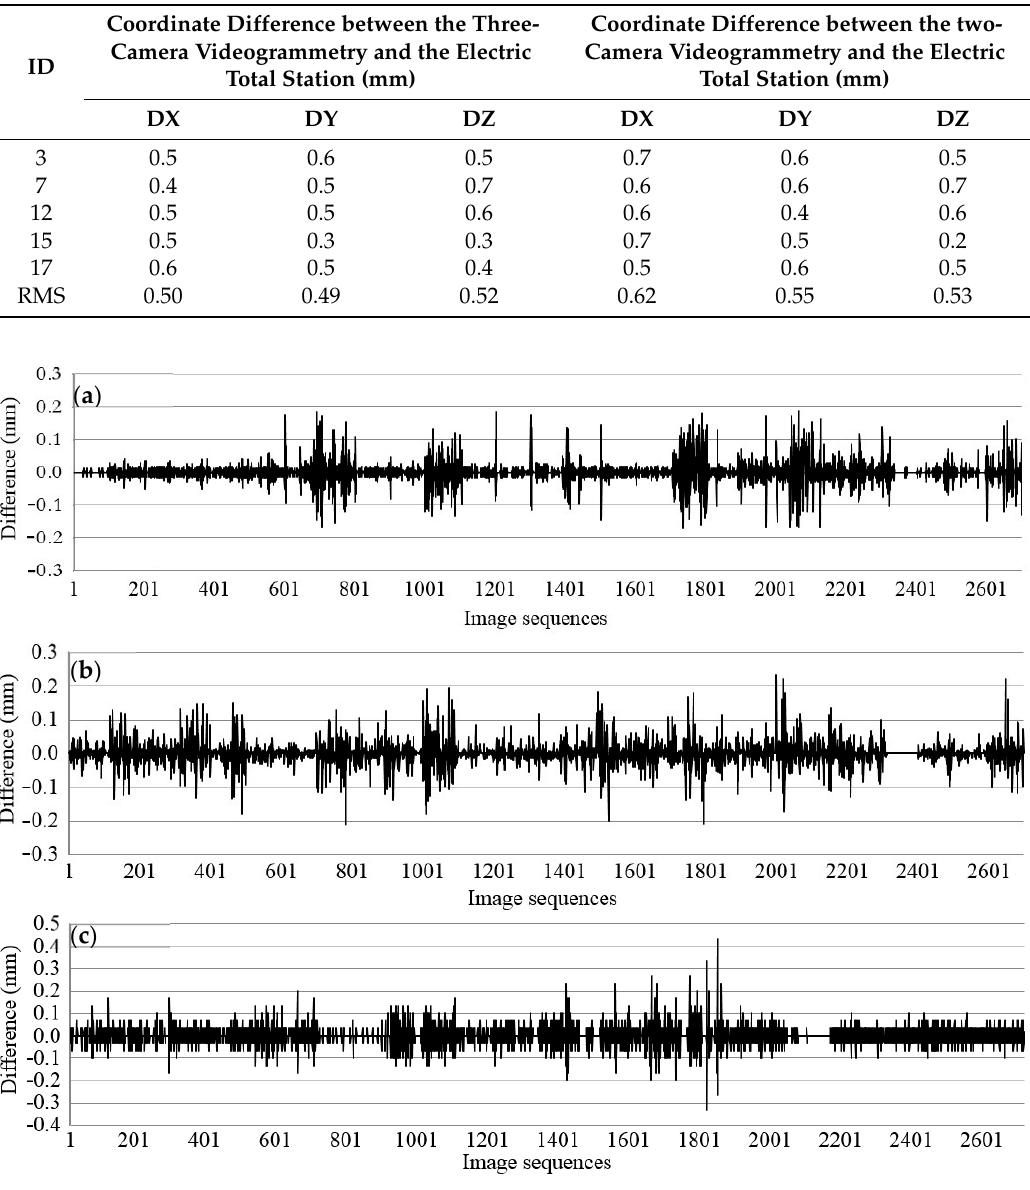
Table 3. Accuracy comparison between the tri-camera videogrammetry and two-camera videogrammetry . Accuracy comparison between the tri-camera videogrammetry and two- camera videogrammetry.